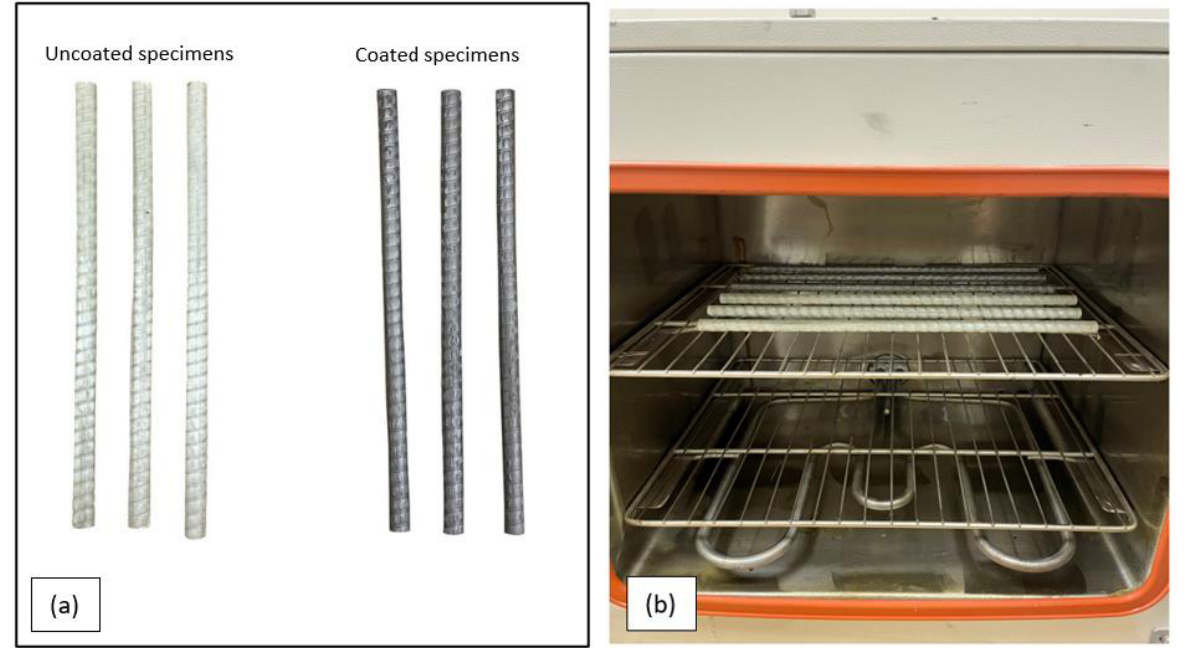
Figure 1. ( a ) Coated and uncoated specimens after cutting. ( b ) Specimens inside the oven .